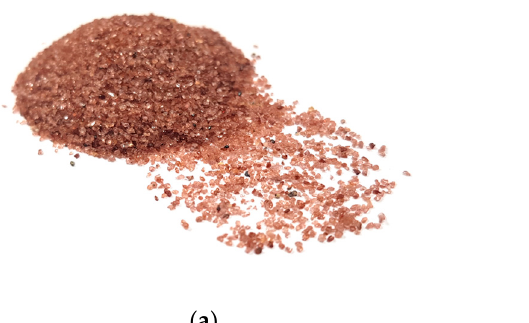
Figure 5. Abrasives for the experiment: ( a ) India garnet; ( b ) particle size distribution. Table 3. Abrasive properties.